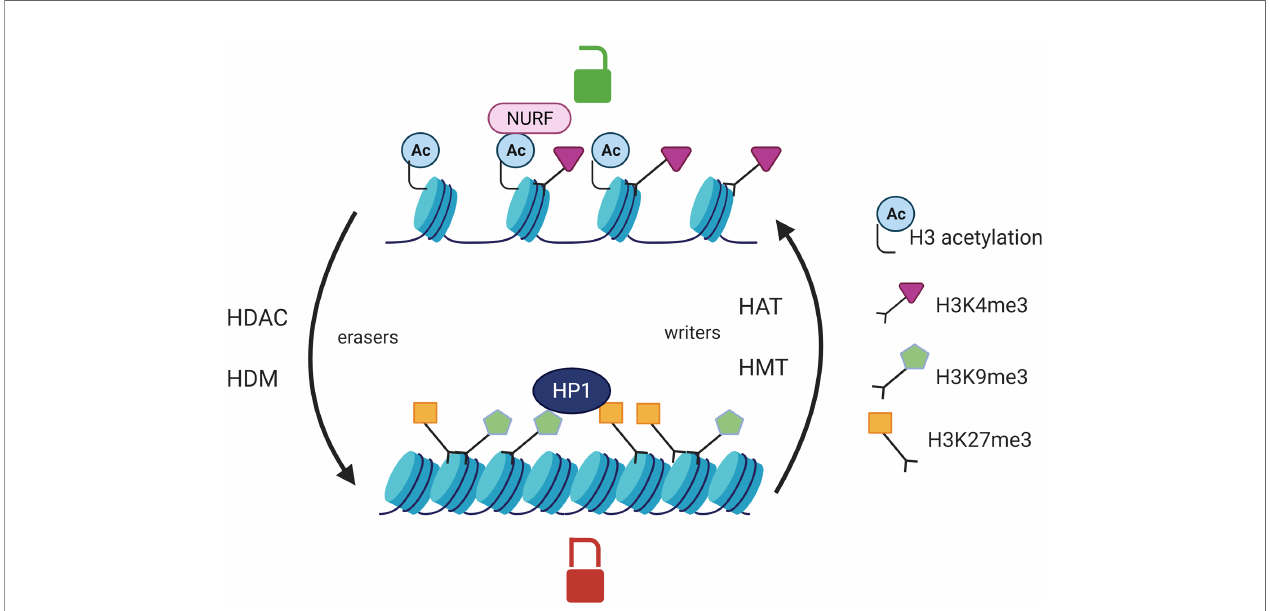
FIGURE 1 | Post translational histone modi fi cations and their effects on transcription. Histone acetylation catalyzed by HAT is associated with an open chromatin whereas HDAC erase this mark and are responsible for chromatin compaction. HMT add methyl groups on the lysines of histone H3 protein whereas HDM catalyze the opposite reaction (eraser). The effect of histone methylation on transcription is variable. HP1 (heterochromatin protein 1) can recognize H3K9me3 or H3K27me3 and is responsible for chromatin silencing. NURF (nucleosome remodeling factor) recognizes the histone mark H3K4me3 and is associated with a chromatin permissive to transcription. HAT, histone acetyltransferases; HDAC, Histone deacetylases; HMT, Histone methyltransferases; HDM, histone